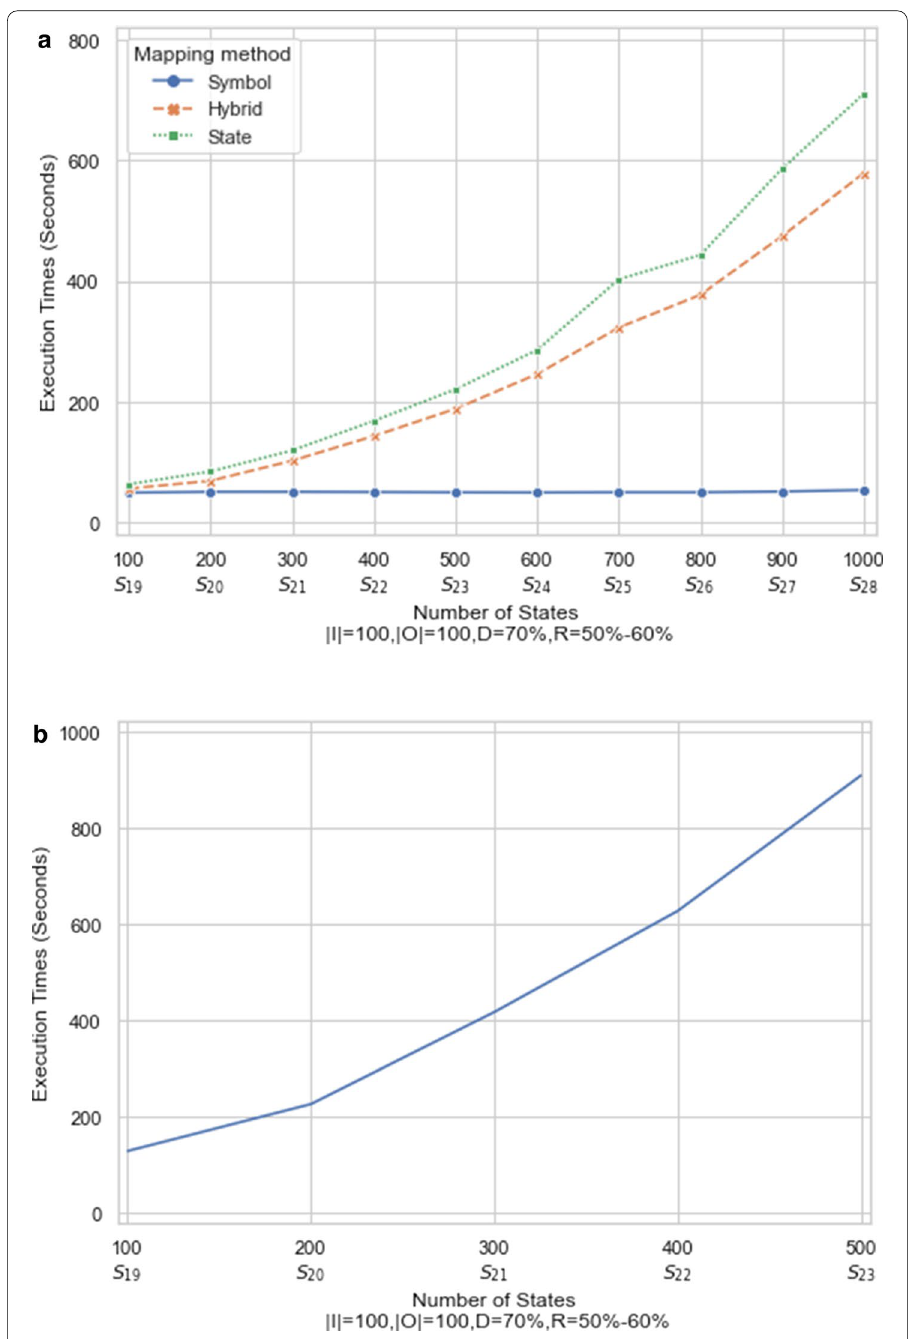
Fig. 7 Execution times versus the number of